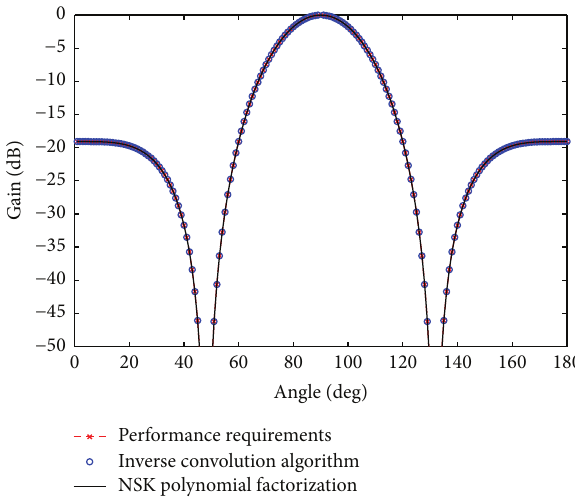
Figure 4: Performance of different